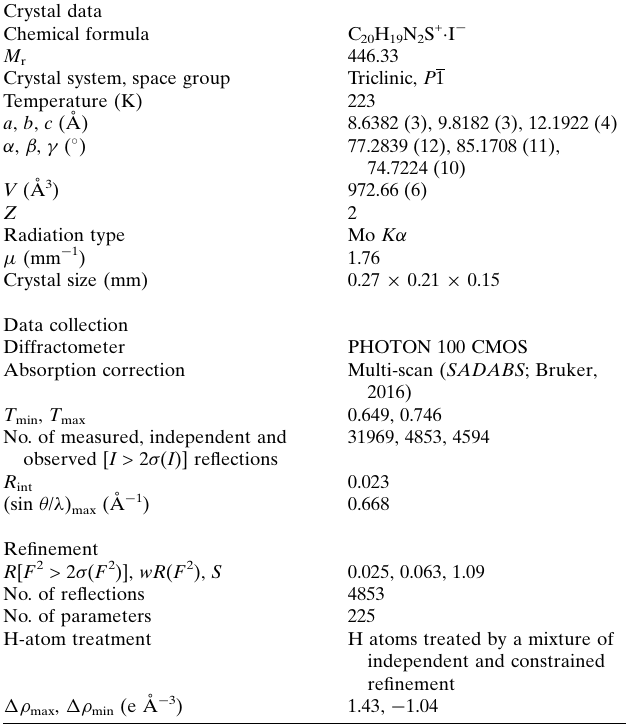
Table 2 Experimental details. Crystal data Chemical